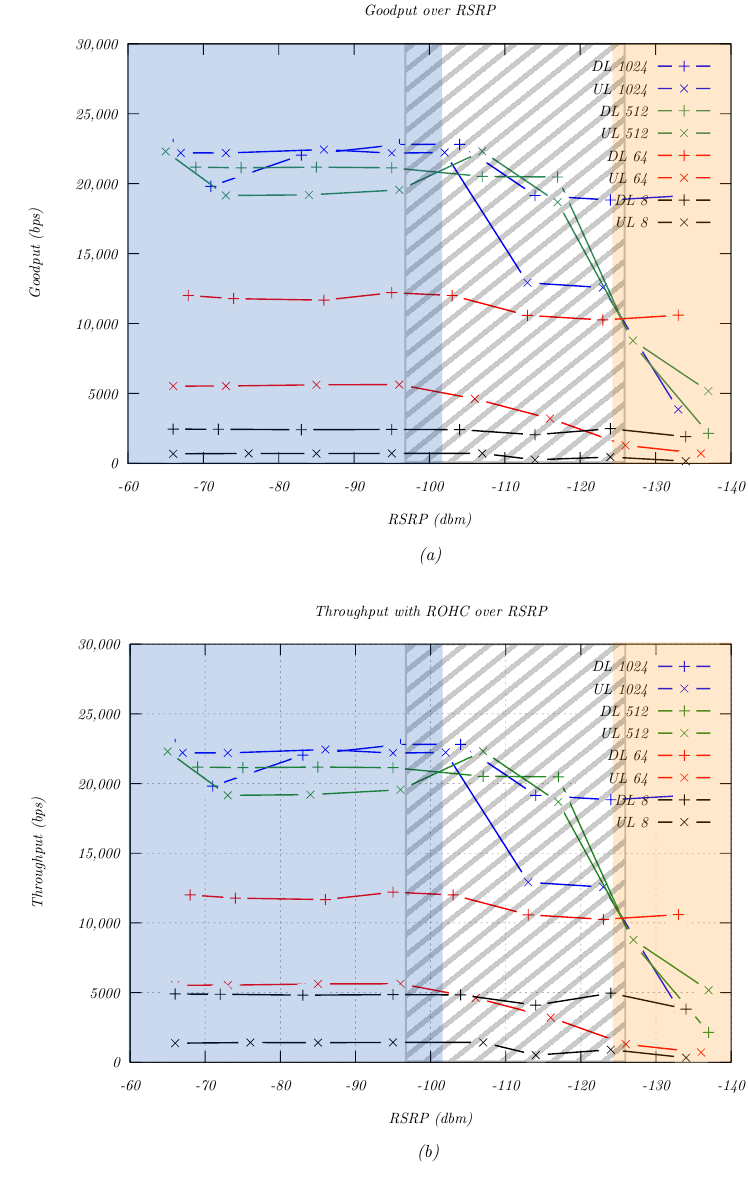
Figure 13. Maximum NB-IoT data rates for various packet sizes and signal levels. ( a ) Goodput excluding protocol headers for different packet sizes. ( b ) Throughput including protocol overhead for different packet sizes. The ECL regions are marked in blue (ECL0), striped (ECL1), and yellow